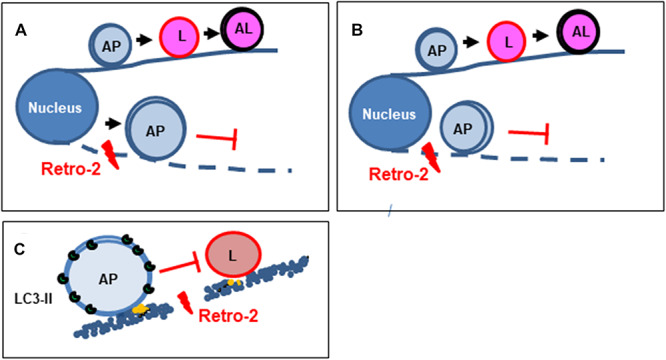
Diagram summarizing the mechanism by which the small trafficking inhibitor Retro-2 modulates MT-dependent vacuolar trafficking in autophagy. (A) Autophagosomes normally move toward lysosomes in a MT-dependent manner to form autolysosomes. By disrupting the MT network, Retro-2 impairs the trafficking of autophagosomes and promotes the cytoplasmic accumulation of very large autophagosomes. (B) Cell nutrient starvation activates the formation of autophagosomes, which spread throughout the cell cytoplasm in an MT-dependent manner. By disrupting the MT network, Retro-2 blocks such spreading of autophagosomes and induces perinuclear accumulation of very large autophagosomes. (C) By disrupting the MT network, Retro-2 impairs the trafficking-dependent formation of autolysosomes. AP, autophagosome; L, lysosome; AL, autolysosome.